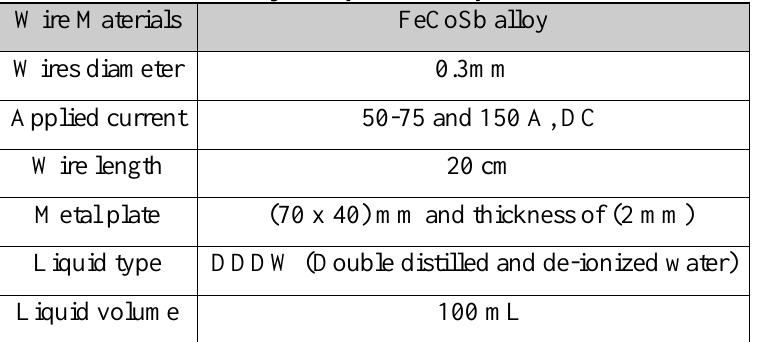
Table 1: Summary of experimental parameters.